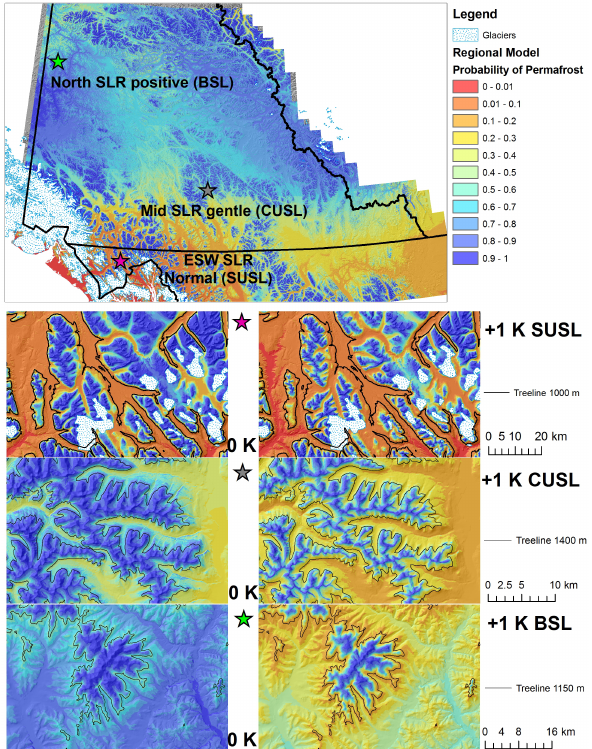
Fig. 12. Examples of modelled permafrost probabilities under RM and RM + 1K scenarios for three different locations and loss pat- terns. Upper map shows the locations of the examples in the paired lower